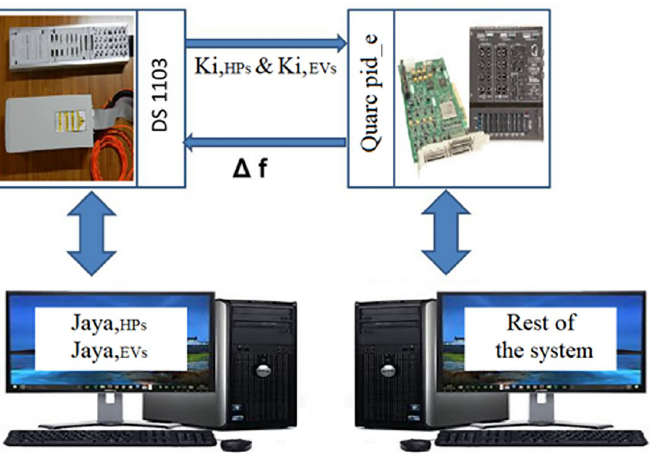
Fig 12. Block diagram of the studied system using real-time simulation.